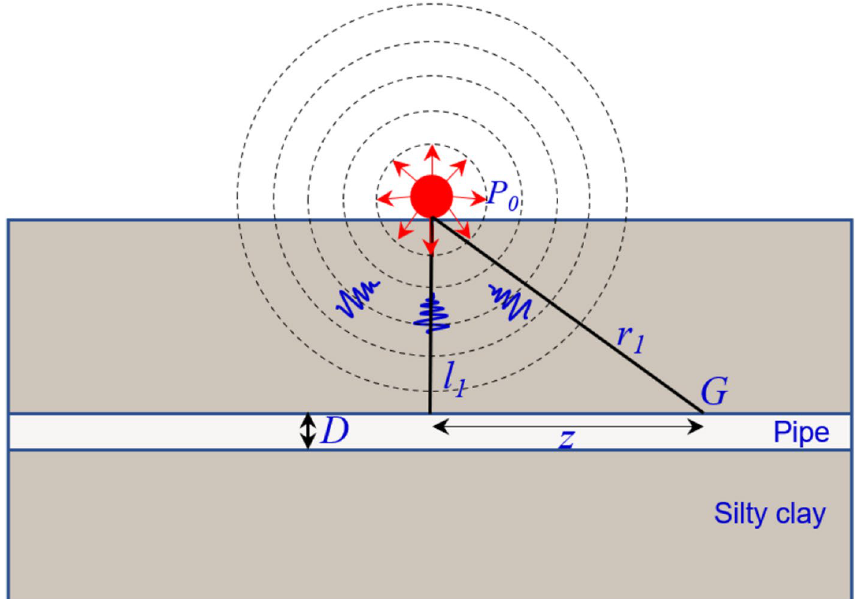
Figure 1. Schematic diagram of the forces on the